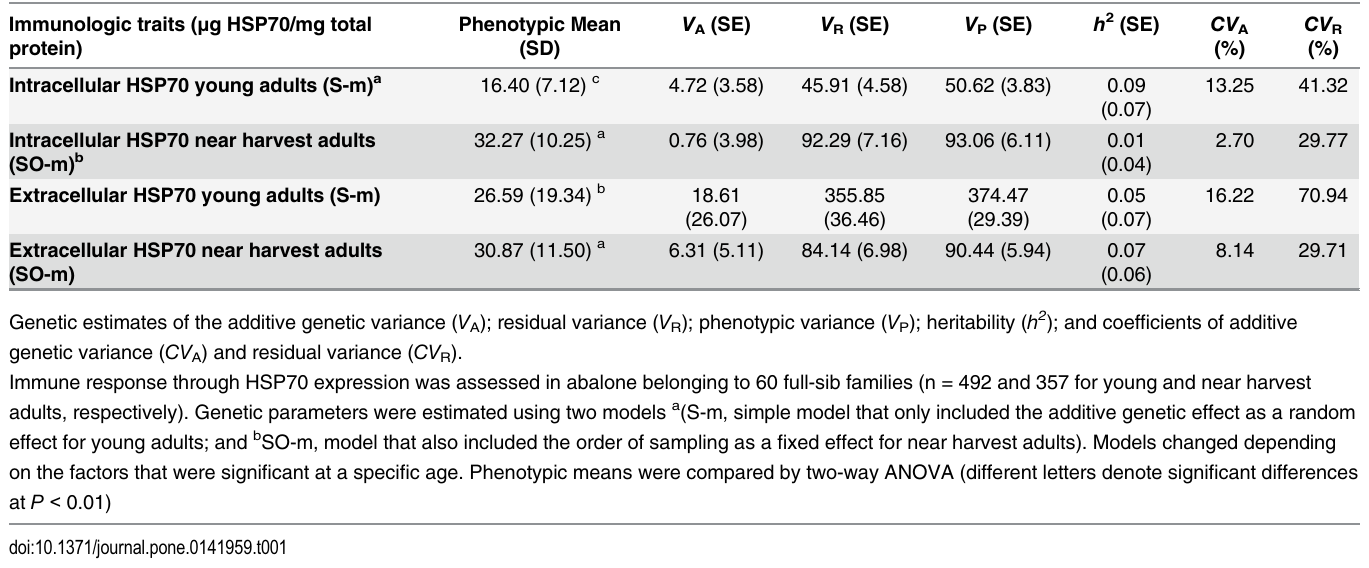
The additive genetic variance ( V ) of the intracellular (haemocytes) and extracellular A ) in both young (serum) HSP70 expression was low compared with the residual variance ( V R adults and pre-harvest adults (Table 1). Accordingly, the estimated h 2 of HSP70 variation in both fractions was low (0.01 – 0.09) and not significantly different from zero (log-LR test, P > 0.05) for both fractions and at both ages. The coefficients of additive genetic variation ) and residual variation ( CV ) in the haemocytes and serum showed much higher values ( CV A R in young adults (13.25 – 16.22%) than in pre-harvest adults (2.7 – 8.14%) (Table 1). The variances for the intracellular and extracellular HSP70 when the information from both of the age classes were combined and estimated from the two mixed models, showed high V R and low V (Table 2) and resulted in low and not significant h 2 (log-LR test, P > 0.05) for A HSP70 in the two haemolymph fractions. In addition, the R of HSP70 expression between the young adult and pre-harvest adult abalones was estimated with both models. Low R values (0 –